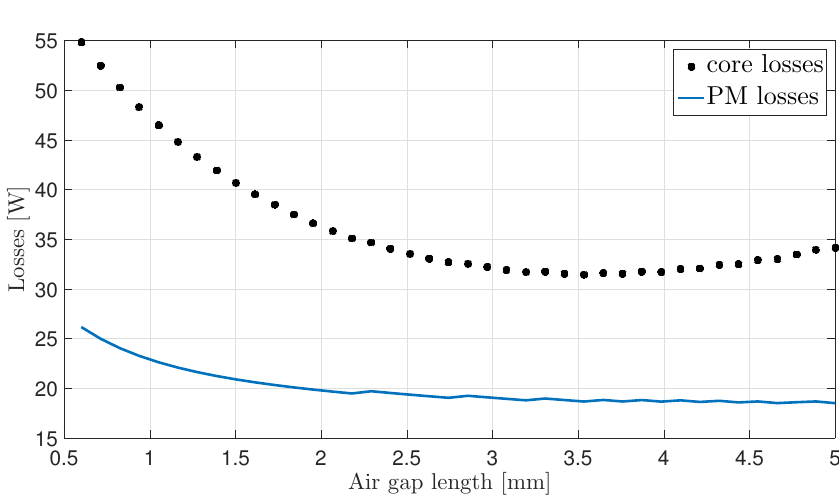
Figure 7. The core and the PM losses variation with the air gap